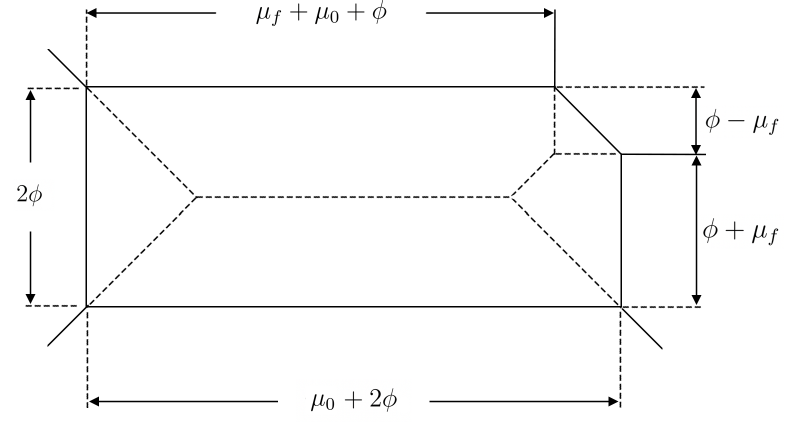
Figure 22 . The brane web diagram for dP 2 theory with positive µ 0 and µ f